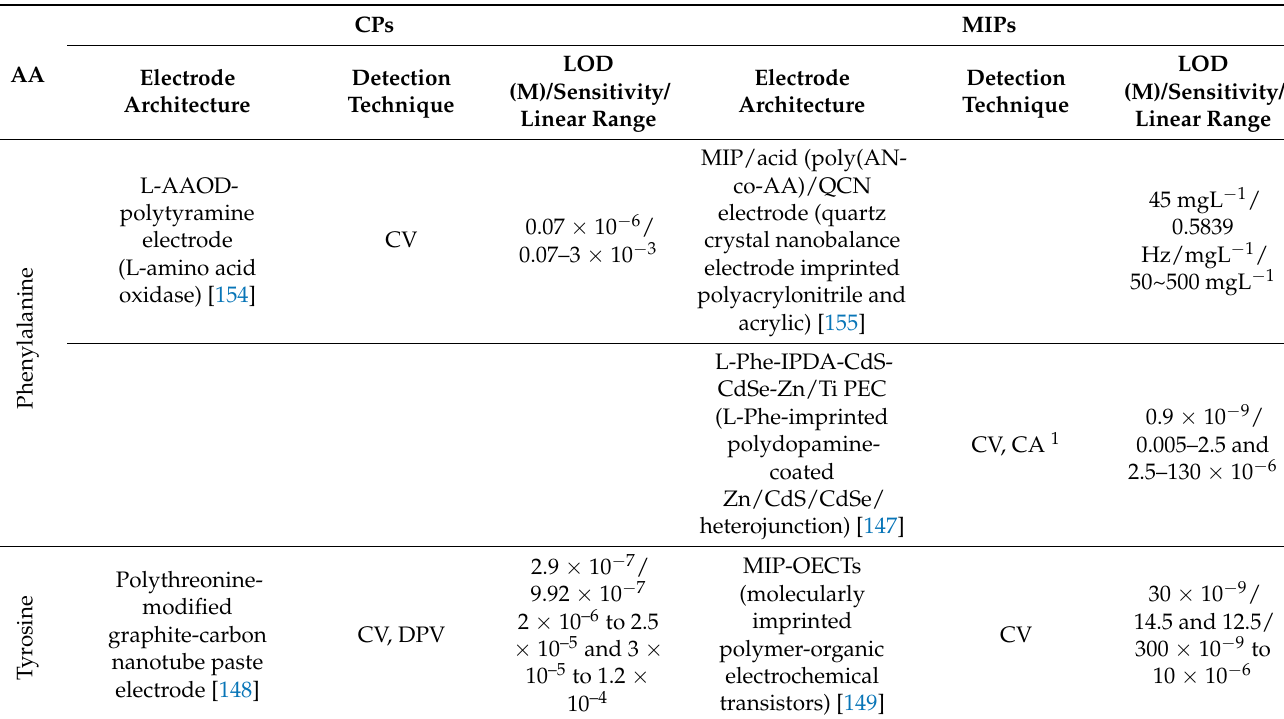
Figure 13. Main elements of a biosensor. Reprinted with permission from [151]. Table 8. Performances of biosensors with CPs and MIPs to detect Phe, Tyr, and